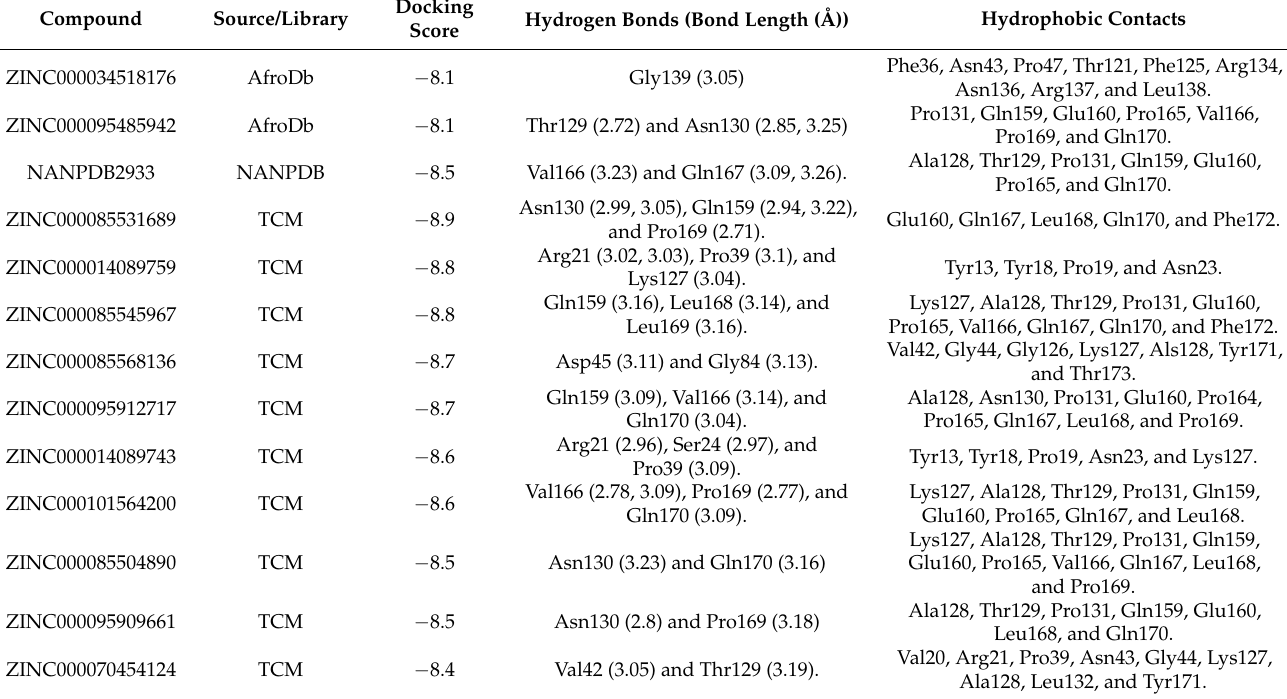
Table 1. Docking scores and interacting residues of some top compounds that were docked into VP40’s NTD.